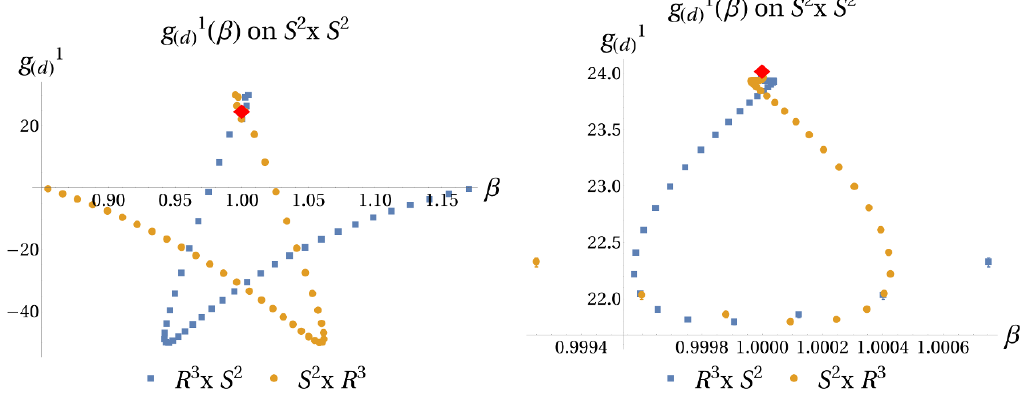
Figure 7 . g 1 as a function of the ratio of radii (cid:12) for both topologies with conformal boundary ( d ) S 2 (cid:2) S 2 . This is proportional to the expectation value of the energy-momentum tensor. The red diamond is the analytical calculation for the singular ratio (cid:12) s .